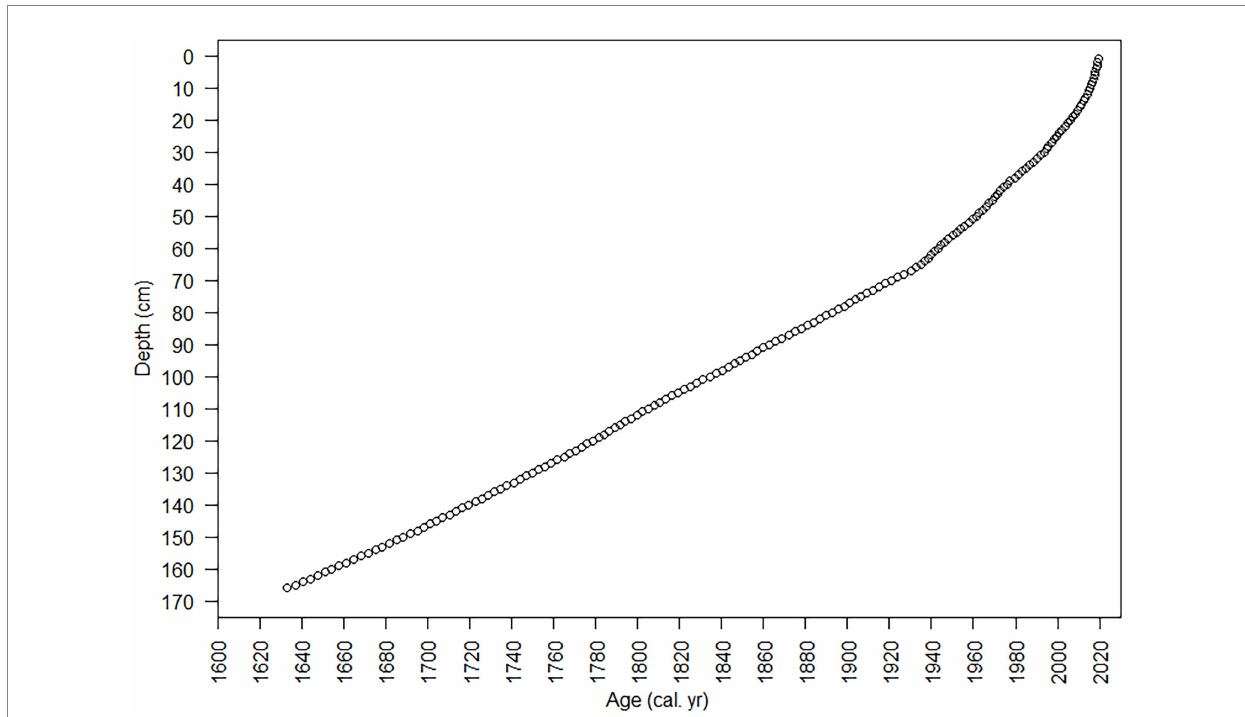
FIGURE 8 Age vs. depth plot from 210 Pb analysis and age models. The 95% confidence intervals for dates estimated with 210 Pb-dating models were small (~ ± 1 year) in the uppermost sample and increased with depth/age to ~ ± 11 year in the deepest sample (80 cm) with 210 Pb unsupported . Dating errors for the CFCS-CRS